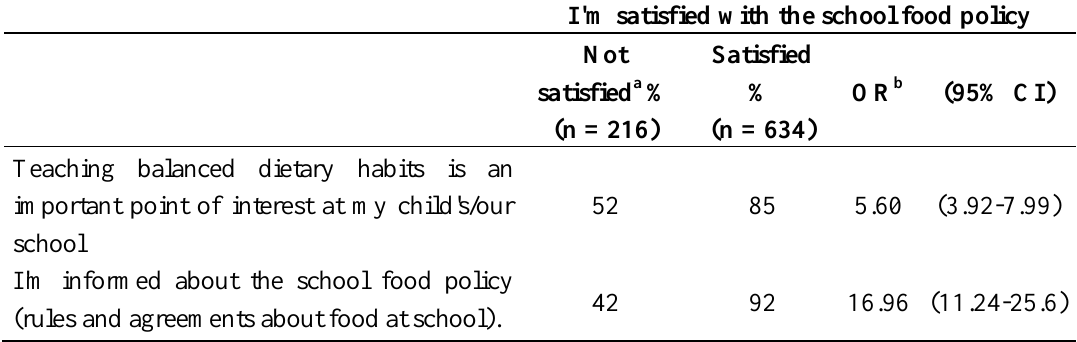
Table 4. Significant results of logistic regression analyses: satisfaction with school food policy as dependent variable and opinions/satisfaction about own school food policy as independent